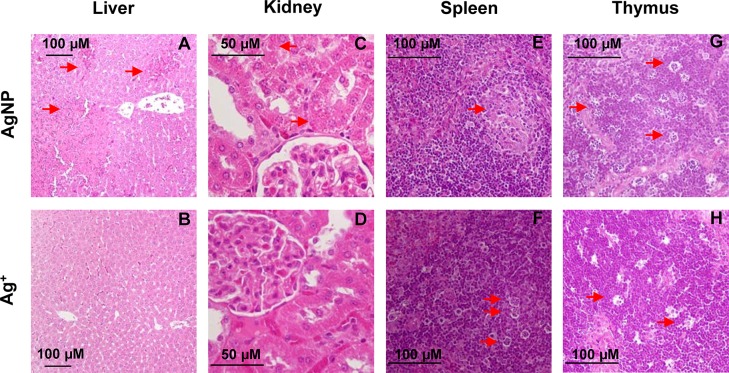
Representative images of histologic changes in liver, kidney, spleen and thymus.All samples prepared from SD rats were hematoxylin and eosin (HE) stained and observed under light microscope (10X-40 X). Moderate multifocal necrosis and hemorrhage of liver cells were observed in animals dosed with AgNP (A), but not in Ag ion group (B). Diffused hyaline degeneration in renal tubular epithelia cell in AgNP group (C), which is absent in Ag ion group (D). In spleen, panel (E) showed the necrosis of lymphocytes in AgNP group, while (F) exhibited the increased tingible body macrophages caused by Ag ion. Increase of tingible body macrophages in thymus was observed in both groups (G-H). Images represent typical samples and changes were indicated using red arrows, n = 3.